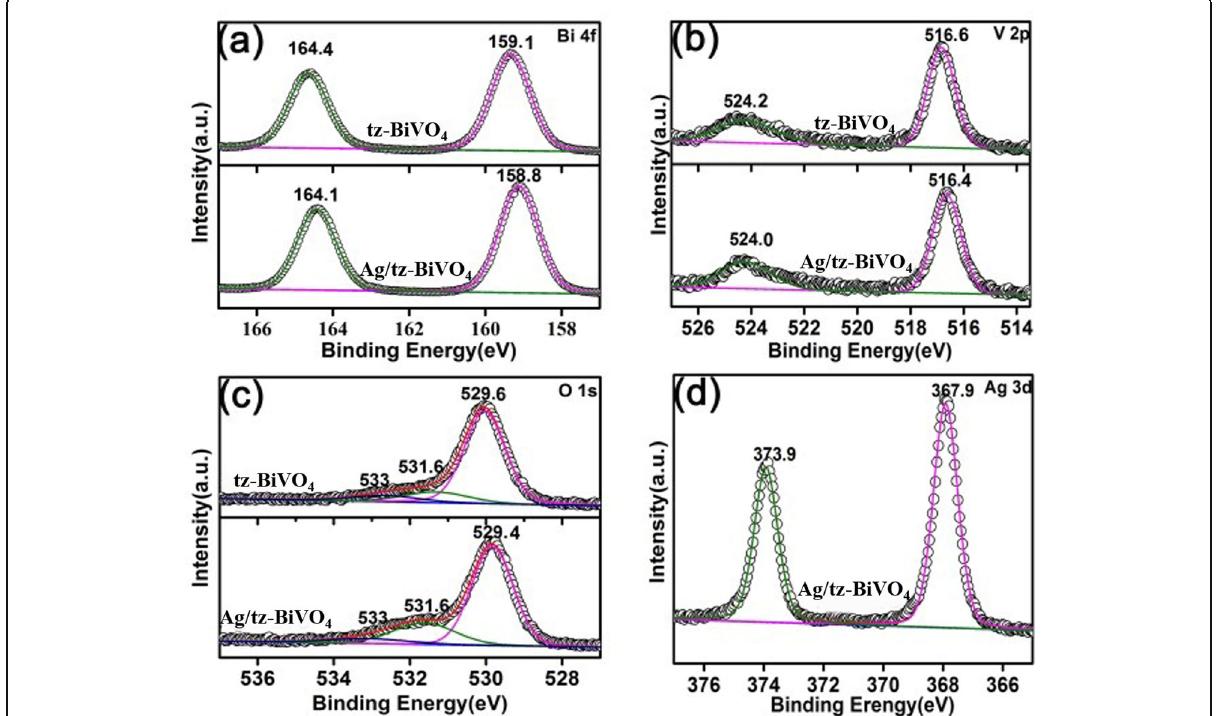
Fig. 2 XPS spectra of tz-BiVO 4 and Ag/tz-BiVO 4 samples: ( a ) Bi 4f, ( b ) V 2p, ( c ) O 1 s, and ( d ) Ag 3d orbital